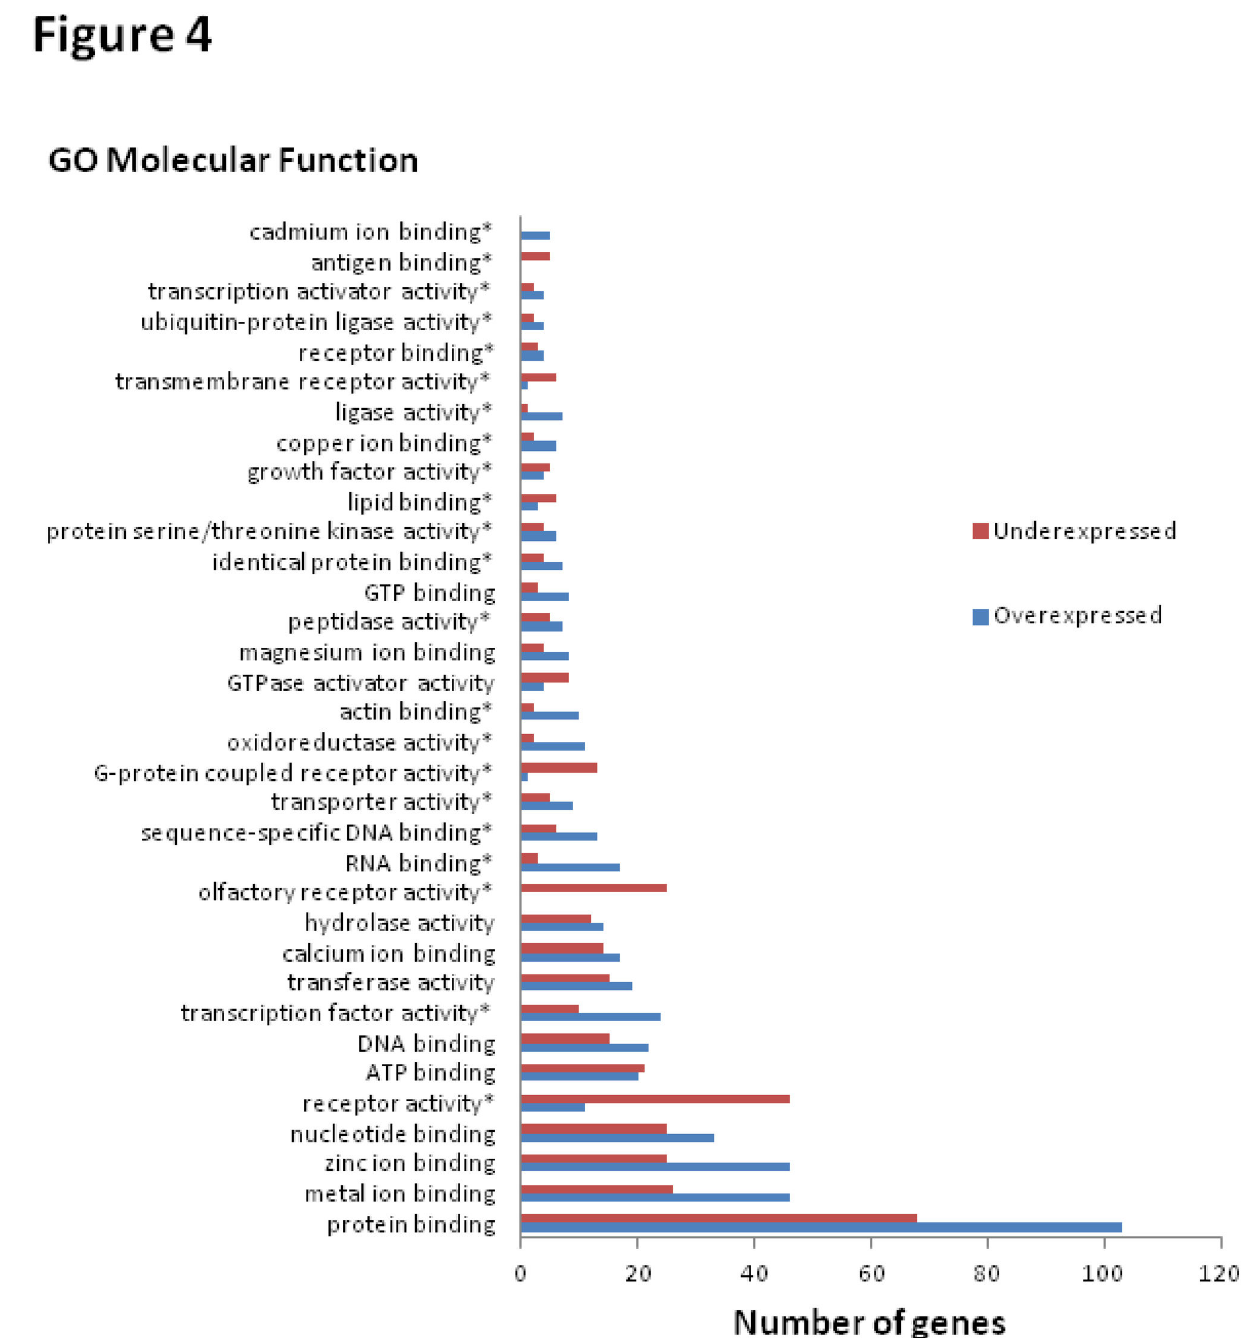
Figure 4. Gene Ontology (GO) categories denoting Molecular Function (MF) information for differentially expressed genes. Information is derived using Onto-Express (http://vortex.cs.wayne.edu/projects.htm). Diagram shows the number of under- and over-expressed genes for each GO MF. The MF marked with stars denotes a statistically significant group ( p <0.05). Only the groups with a gene number ≥ 5 are